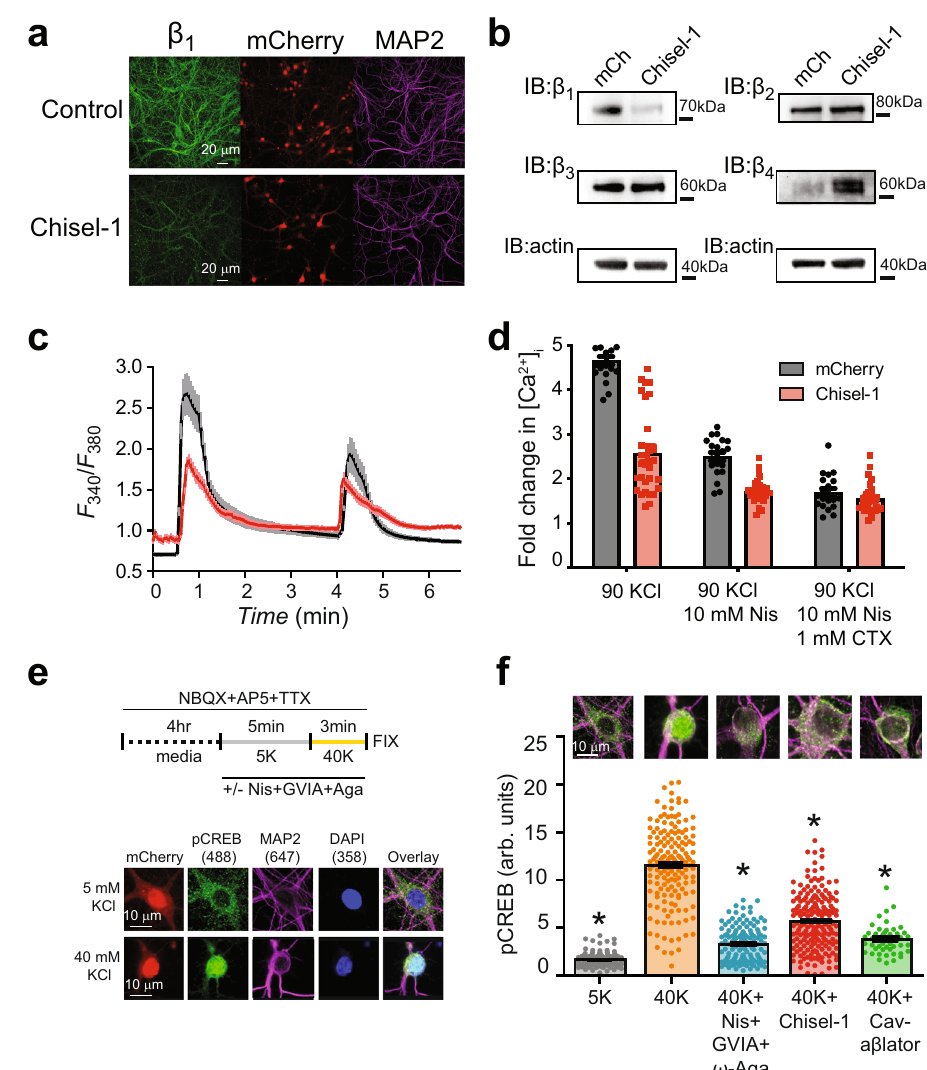
Fig. 9 | Chisel-1 inhibits Ca 2+ in fl ux and excitation-transcription coupling in hippocampalneurons.a Representativehippocampalneuronculturesexpressing mCherry (top row) or Chisel-1-P2A-mCherry (bottom row) with immuno- fl uorescencedetectionof β 1b (green)andMAP2(purple).Imagesarerepresentative of three independent experiments. b Representative Ca V β isoform immunoblots from hippocampal neurons expressing either mCherry or Chisel-1. Immunoblots are representative of three independent experiments. c Time course of mean 90 KCl-evoked Ca 2+ transients in hippocampal neurons expressing either mCherry (black line) or Chisel-1 (red trace). d Bar charts showing impact of Chisel-1 on 90 KCl-evoked Ca 2+ transients before and after the addition of Ca V 1/Ca V 2 channel blockers (mCherry, n =20 over 3 independent experiments; Chisel-1, n =30 over 3 independent experiments). e Top, schematic of experimental protocol for asses- sing excitation-transcription coupling in cultured hippocampal neurons.